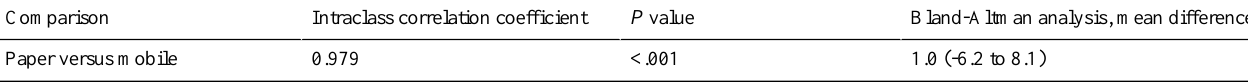
Table 3. Consistency analysis of paper and mobile